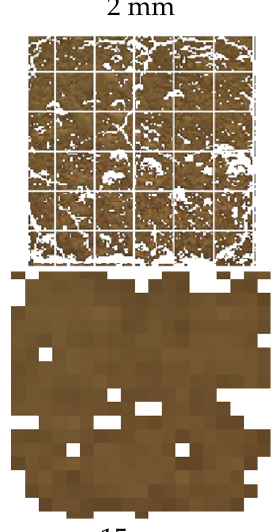
Figure A1. Example of the procedure for shadow threshold individuation on a soil multispectral image: difference in reflectance between illuminated and shadowed calibration pixel ( a ) and the brightness curves after sorting and detrending to make the shadow threshold stand out as a local maximum ( b ).